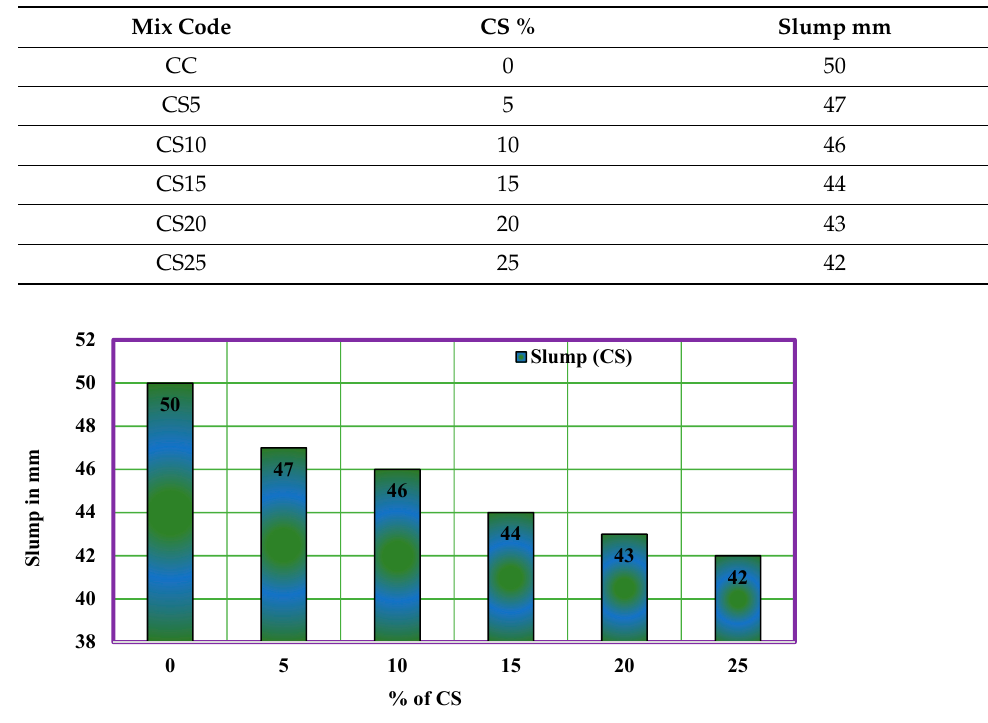
Table 2. Slump of CS concrete.